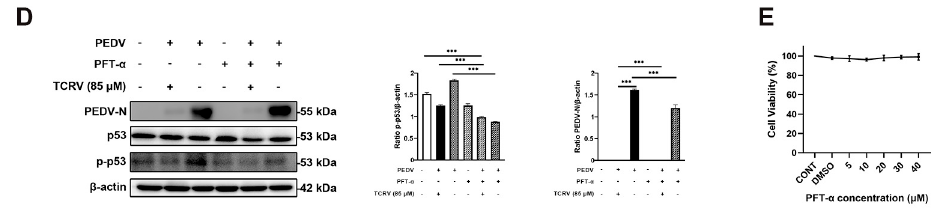
Figure 7. TCRV inhibits PEDV infection through the regulation of caspase-3. ( A ) Western blotting analysis of PEDV N, cleaved caspase-3, and caspase-3 proteins in PEDV-infected Vero cells treated with 85 µ M TCRV and 50 µ M Z-DEVD-FMK at 24 hpi. Results were presented as the ratio of band intensities of the target protein to β -actin. ( B ) PEDV-infected cells were treated with 85 µ M TCRV and 50 µ M Z-DEVD-FMK at 24 hpi. Apoptosis was analyzed using Annexin V-PE/7AAD staining, and the apoptotic cells were explored using flow cytometry. The Annexin V-positive cells were considered apoptotic cells. ( C ) Determination of the cytotoxicity of Z-DEVD-FMK (30 µ M, 40 µ M, 50 µ M, 60 µ M, and 70 µ M) by the CCK-8 assay. ( D ) Western blotting analysis of PEDV N, p-p53, and p53 proteins in PEDV-infected Vero cells treated with the indicated concentrations of TCRV and PTF- α (20 µ M) at 24 hpi. Results were presented as the ratio of band intensities of the target protein to β -actin. ( E ) Determination of the cytotoxicity of PTF- α (5 µ M, 10 µ M, 20 µ M, 30 µ M, and 40 µ M) by the CCK-8 assay. Data from three independent experiments and error bars are presented as the mean ± SEM. *** p <